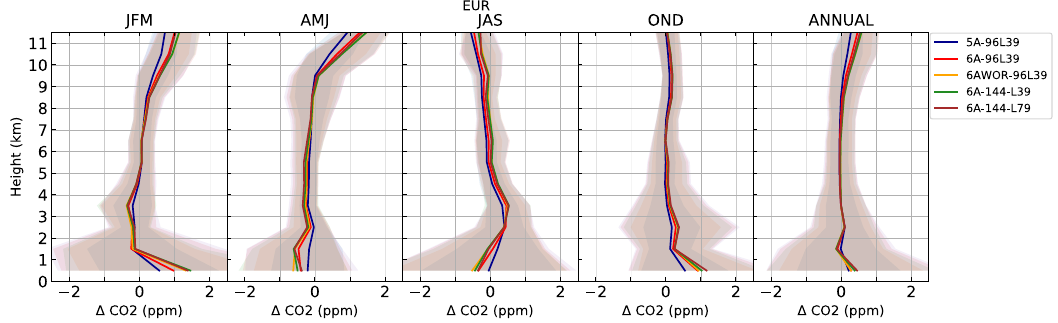
Figure 11. Same as for Fig. 10 but over Europe from the CONTRAIL dataset during the period 2006–2011. The domain is portrayed in Fig.